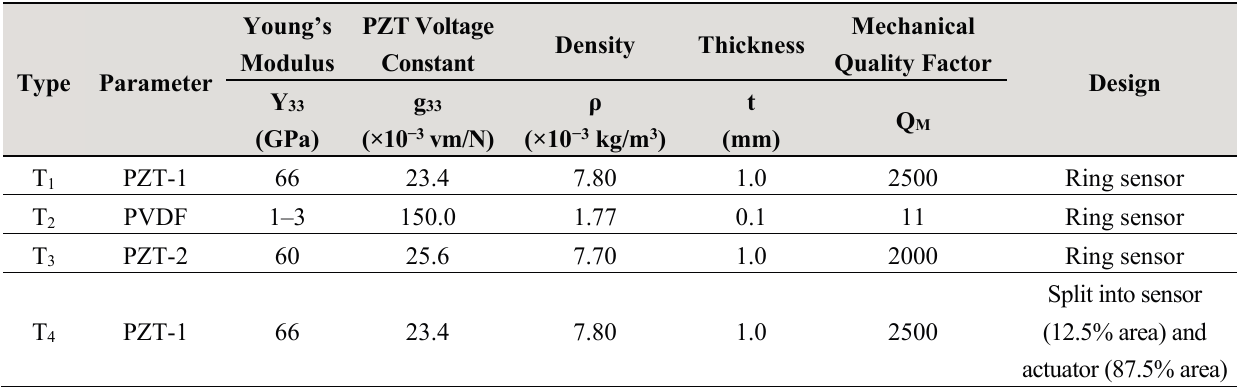
Table 2. Properties of PZT sensor